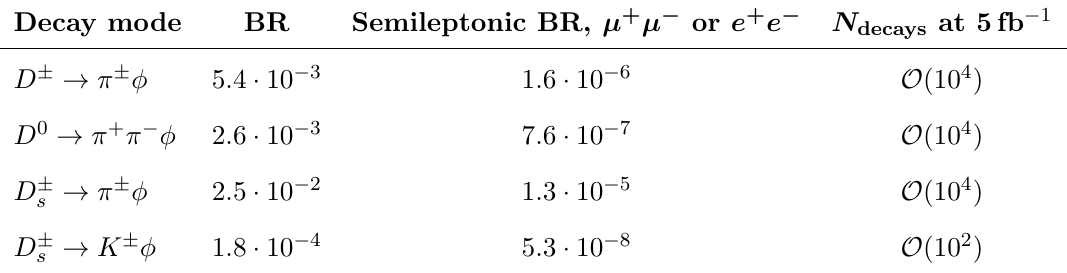
Table 2 . Collection of D (cid:6) ; D 0 ; and D s meson decay modes with which tests of lepton univer- sality of the (cid:30) meson are possible at LHCb. The individual branching ratios are extracted using PDG tables [44], while the leptonic branching to individual (cid:13)avors is obtained by multiplying with BR ( (cid:30) ! ‘ + ‘ (cid:0) ), which we take to be 2 : 9 (cid:1) 10 (cid:0) 4 . The estimates for the number of expected events with 5 fb (cid:0) 1 is obtained by a simple rescaling of results from ref.